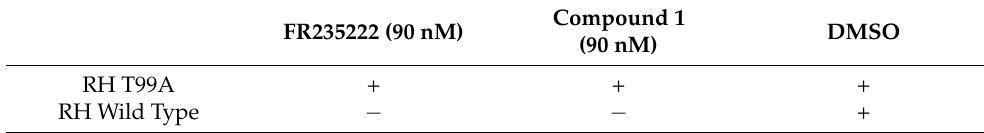
Table 2. Compound 1 efficiency on RH Tg HDAC3 T99A strain and on an RH wild-type strain compared to FR235222 (positive control) and DMSO (negative control). +: Tachyzoite prolifera- tion leading to HFF cell lysis in cell culture observed by inverted microscopy. − : No tachyzoites proliferation with no cell lysis in cell culture observed by inverted